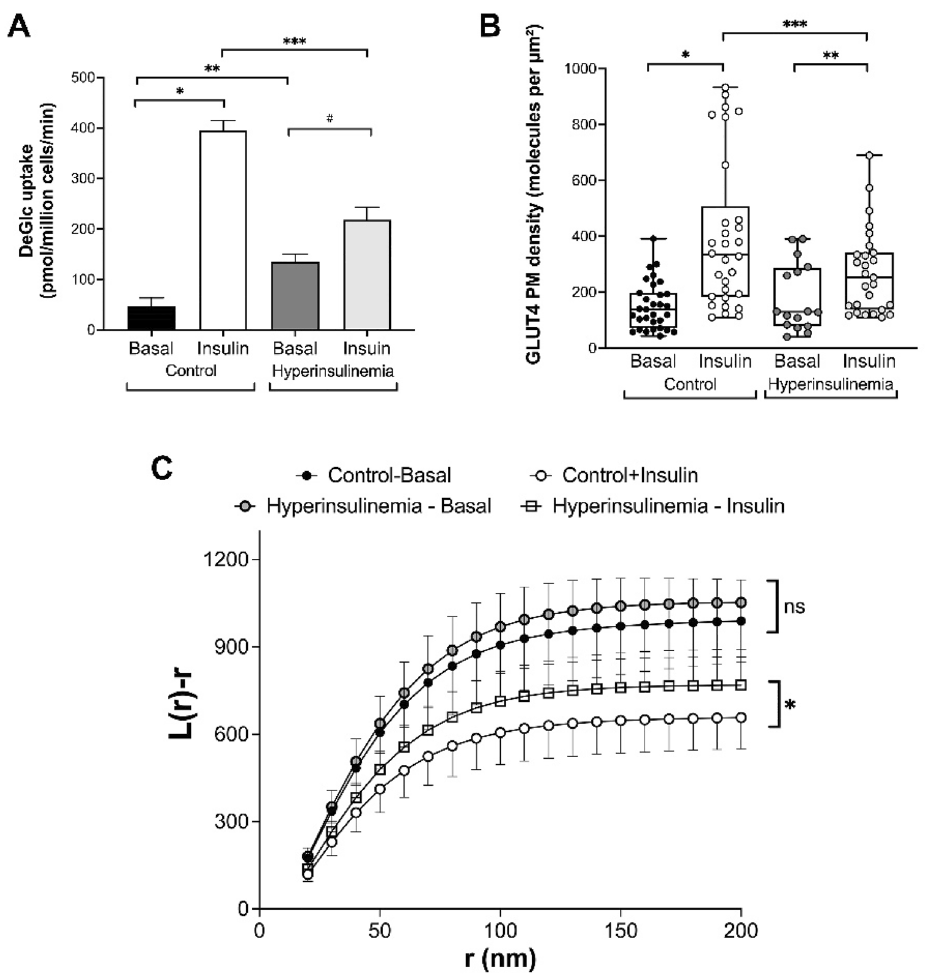
Figure 3. Chronic insulin treatment modulates GLUT4 translocation and dispersal. 3T3-L1 adipocytes were incubated in normal media or in media supplemented with 500 nM insulin for 24 h (‘hyperinsulinemia’ in the figure) before washing as described in Methods . ( A ) shows the rates of 2-deoxyglucose (DeGlc) transport in response to an acute insulin challenge (100 nM, 20 min); insulin robustly stimulates glucose transport in control cells (8.4-fold; * p < 0.0001). Hyperinsulinemia results in elevated basal (insulin-independent) DeGlc uptake (2.8- fold, ** p = 0.0002) and impairs the response to an acute insulin addition (reduced to 1.6-fold; # p = 0.0013). The maximal rate of insulin stimulated DeGlc transport was reduced under hyperinsulinemia (from 394 pmol/min/ million cells to 218 pmol/mon/million cells; *** p < 0.0001). Data shown is from 4 independent experiments; statistical analysis by one-way ANOVA. We used 3T3-L1 adipocytes expressing HA-GLUT4-GFP to measure GLUT4 plasma membrane density ( B ) and GLUT4 dispersal ( C ) under the same conditions. ( B ) Insulin increased GLUT4 density in the plasma membrane 2.7-fold (* p < 0.0001) in control cells. In chronic insulin treated cells, the ability of insulin to increase GLUT4 levels was reduced (1.5-fold, ** p = 0.044); each point is a measurement from a single cell. The maximal GLUT4 density in response to insulin was reduced in chronic insulin treated cells (*** p = 0.03). ( C ) shows estimates of L(r) under basal and insulin-stimulated conditions one-way ANOVA, Tukey’s HSD Test). Acute insulin stimulation resulted in GLUT4 dispersal in both control and chronic insulin-treated cells. However, chronic insulin treated cells exhibited reduced GLUT4 dispersal